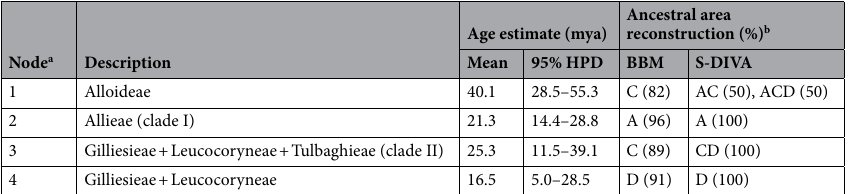
Table 2. Posterior age distributions of major nodes of Allioideae using BEAST, with results of ancestral area reconstruction using BBM and S-DIVA analyses. Ancestral areas include: (A) Eurasia, (B) North America, (C) Africa, (D) South America, and (E) Australia. a Node numbers and biogeographic codes correspond to those in Figs. 3, 4. b Ancestral areas for each node are represented with marginal probability ≥ 10%.